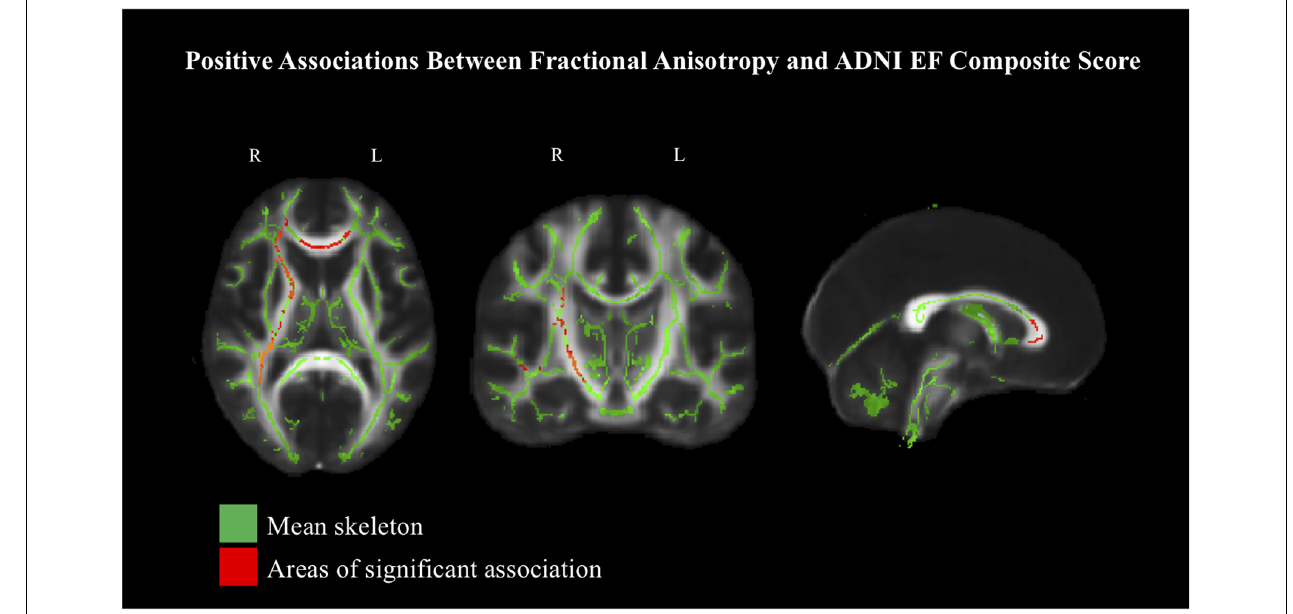
FIGURE 2 | Positive associations between COM-EF and white matter, based on fractional anisotropy (FA) at 90% threshold, depicted in radiological view. Mean FA skeleton shown in green. Areas of significant association shown in red.